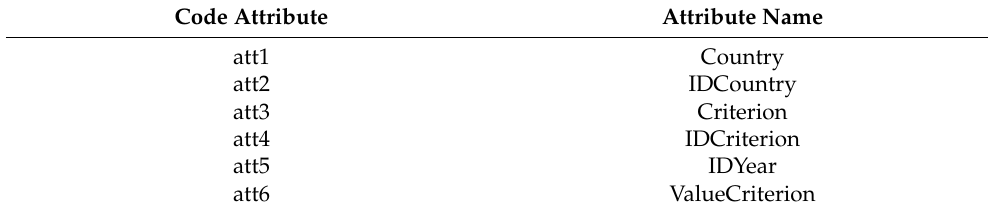
Table 4. Inflation: attributes of the time series.